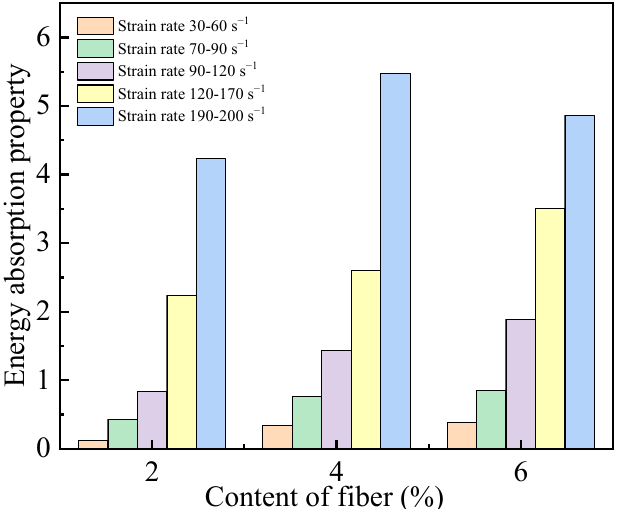
Figure 8. Influence of fiber content on energy absorption property in dynamic impact test